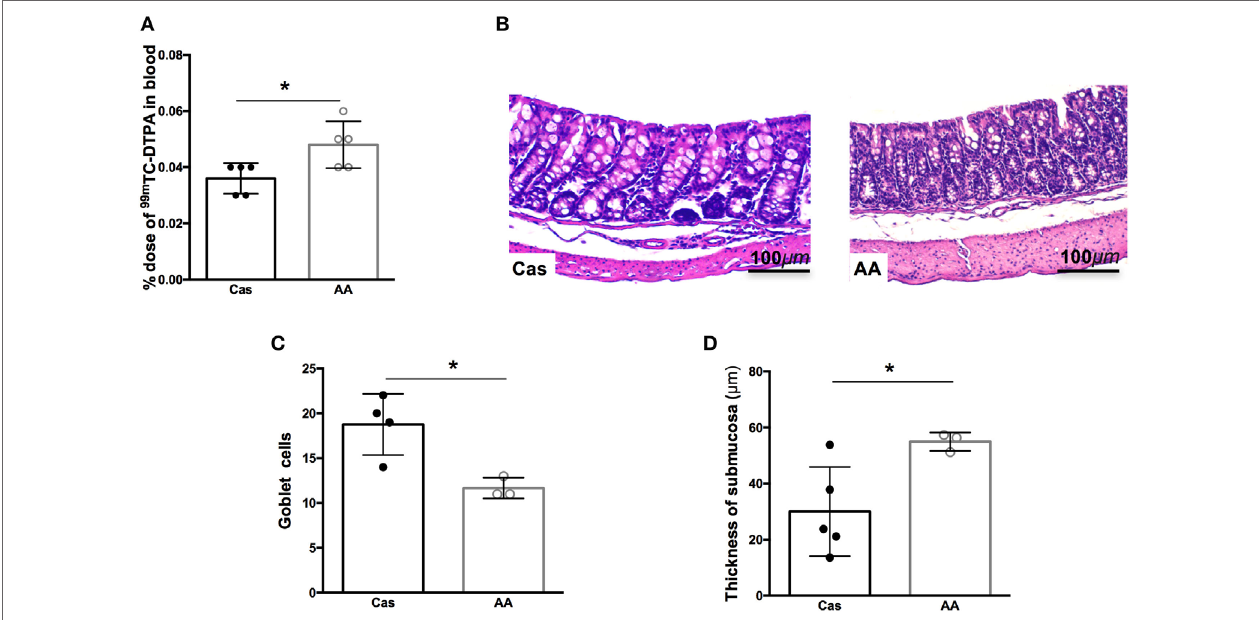
FigUre 4 | Histological analysis of the small intestine after dietary consumption. C57BL/6 mice at 7–8 weeks of age were fed either experimental diet [diet containing free amino acids (AA diet)] or control diet [casein-containing diet (CAS diet)] for 5 weeks. Intestinal permeability was determined by% dose/g of 99 m-technetium (99mTc)-diethylenetriamine penta-acetic acid (DTPA) in blood (a) . Representative images of CAS-fed and AA-fed mice after 35 days of dietary consumption (b) . Analysis and measurement of goblet cell numbers (c) , and thickness of the submucosa (D) were performed in at least three mice per group at 40 × magnification. Analysis was performed at 10 × magnification. Statistical analysis was performed between CAS-fed and AA-fed group using Mann–Whitney test for non-parametric data. p <